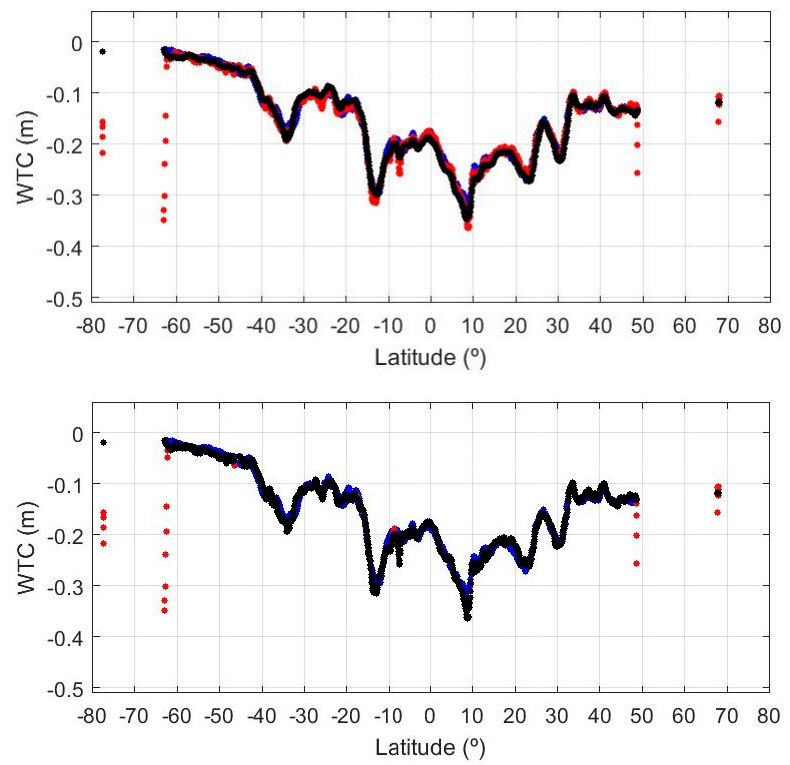
Figure 12. WTC (in metres) for S3A pass 340, cycle 06: ECMWF Operational (blue), MWR (red) and GPD (black, GPD1 in the top plot, GPD2 in the bottom plot) functions of latitude. The plot order is as mentioned in this caption. Thus, whenever the blue points cannot be seen, they are overlaid by the red and/or black points.